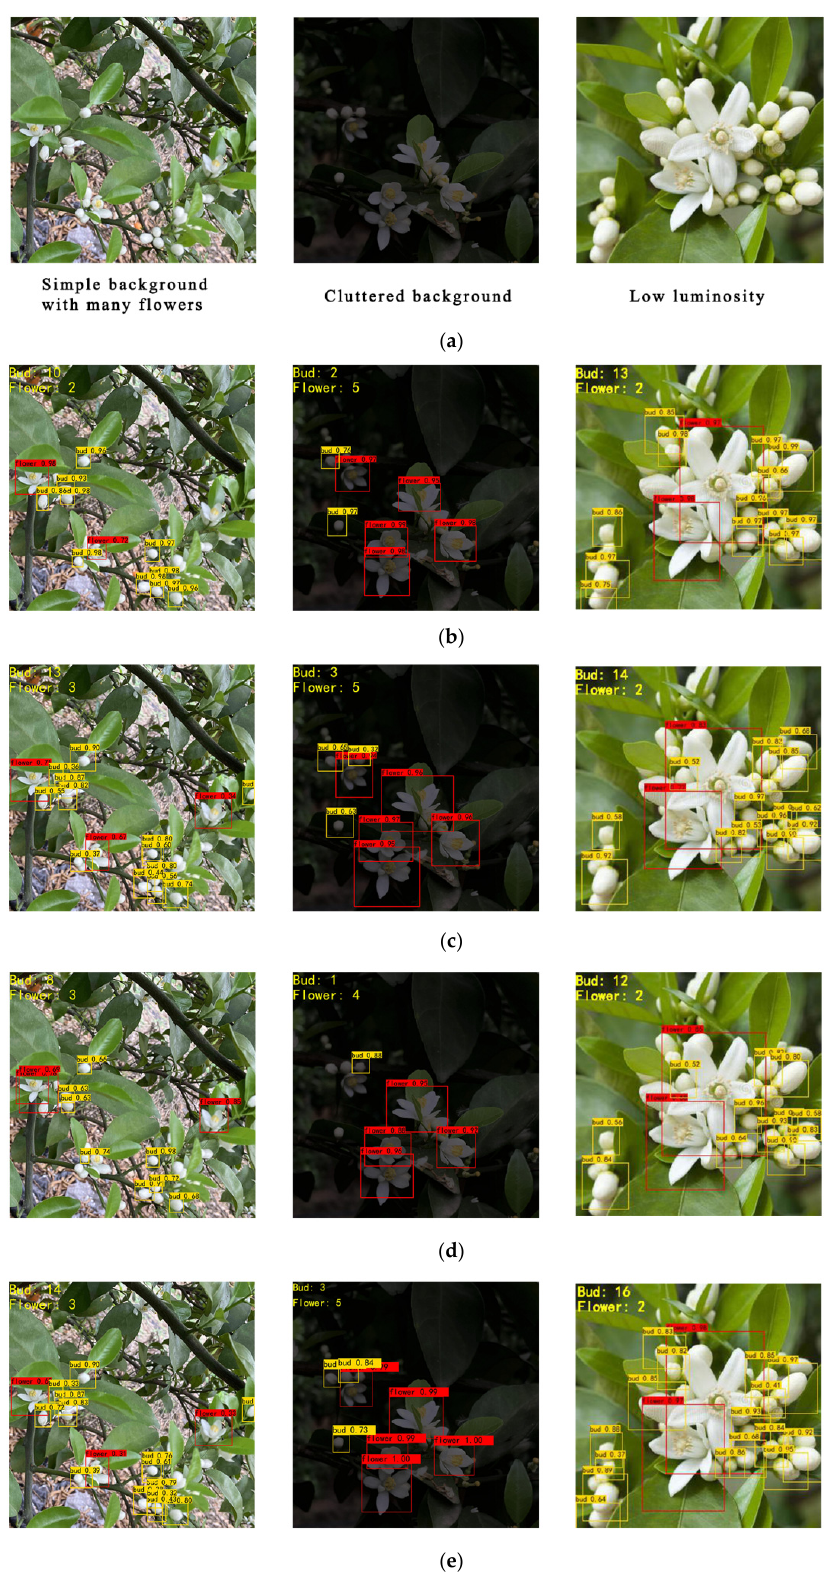
Figure 10. The detection effects of different models under different conditions. ( a ) Original images. ( b ) The detection results of YOLOv4. ( c ) The detection results of improved YOLOv4. ( d ) The detection re-sults of YOLOv4-tiny. ( e ) The detection results of Faster